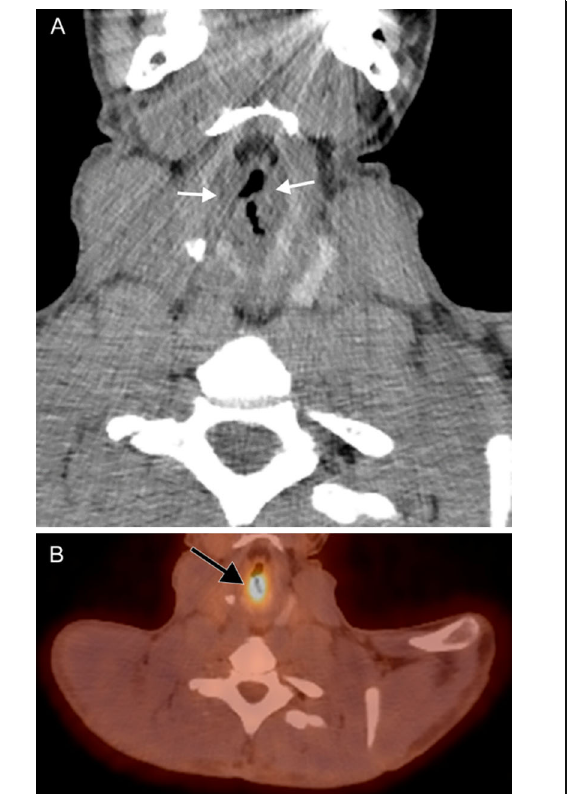
Fig. 8 Laryngeal papillomatosis. A 26-year-old man with recurrent tracheal/laryngeal papillomatosis status post tracheal diversion and radiation therapy. A coronal contrast-enhanced CT image ( a ) reveals nodular soft tissue attenuation (white arrows) replacing the laryngeal structures. Subsequent axial attenuation-corrected PET image ( b ) reveals marked FDG-avidity (black